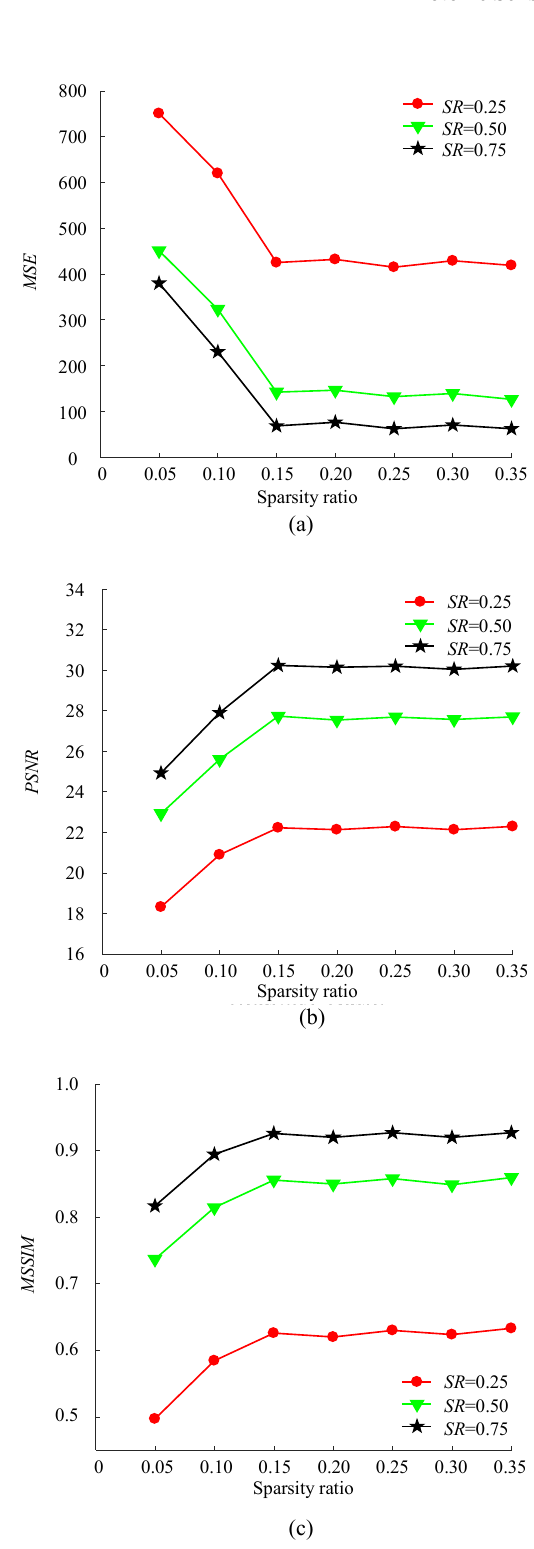
Fig. 6 Effect of matrix sparsity ratio on its performance. With SRs of 0.25, 0.50, and 0.75, the parameters MSE (a), PSNR (b), and MSSIM (c) change with sparsity ratio of the measurement matrix. Each group of experiments is repeated 500